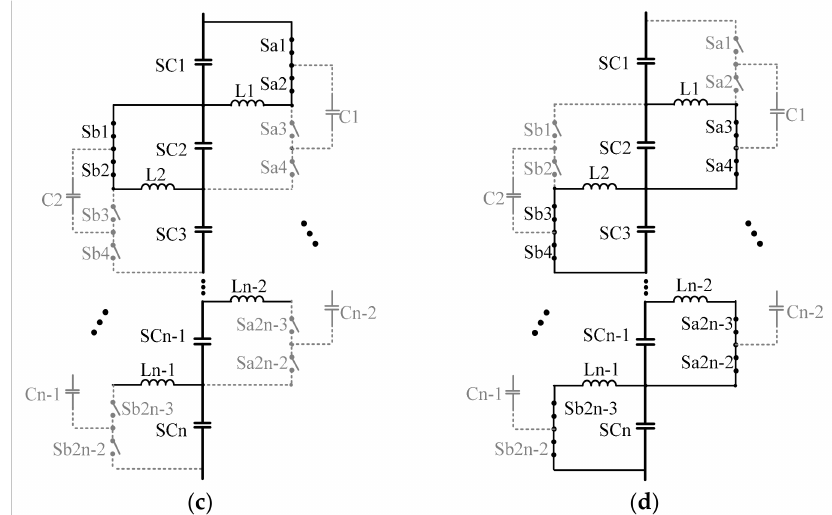
Figure 4. Working principle of the proposed balancing system. ( a ) ZCS mode state I; ( b ) ZCS mode state II; ( c ) buck-boost mode state I; ( d ) buck-boost mode state II.